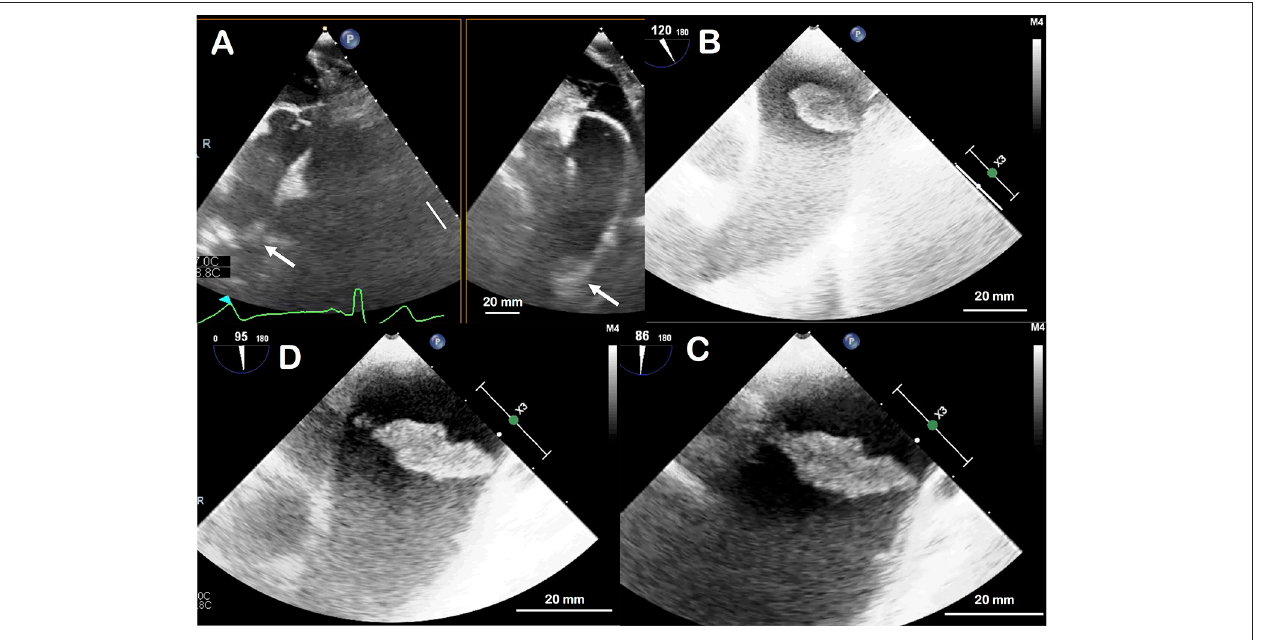
FIGURE 2 | Transoesophageal ultrasound appearance of the thrombus in the aortic arch. Not visible on the initial part of the ascending aorta, it appears only in deep transgastric view by aligning the thoracic aorta (A) ; white arrow indicates the thrombus. It is located 6cm far from the aortic valve. The thrombus is then well-visualized by removing the ultrasound probe and aligning the aortic arch (B) . By zooming in on the thombus, it appears as a large, mobile and irregular thrombus, attached to a small base at the upper part of the aortic arch (C,D)